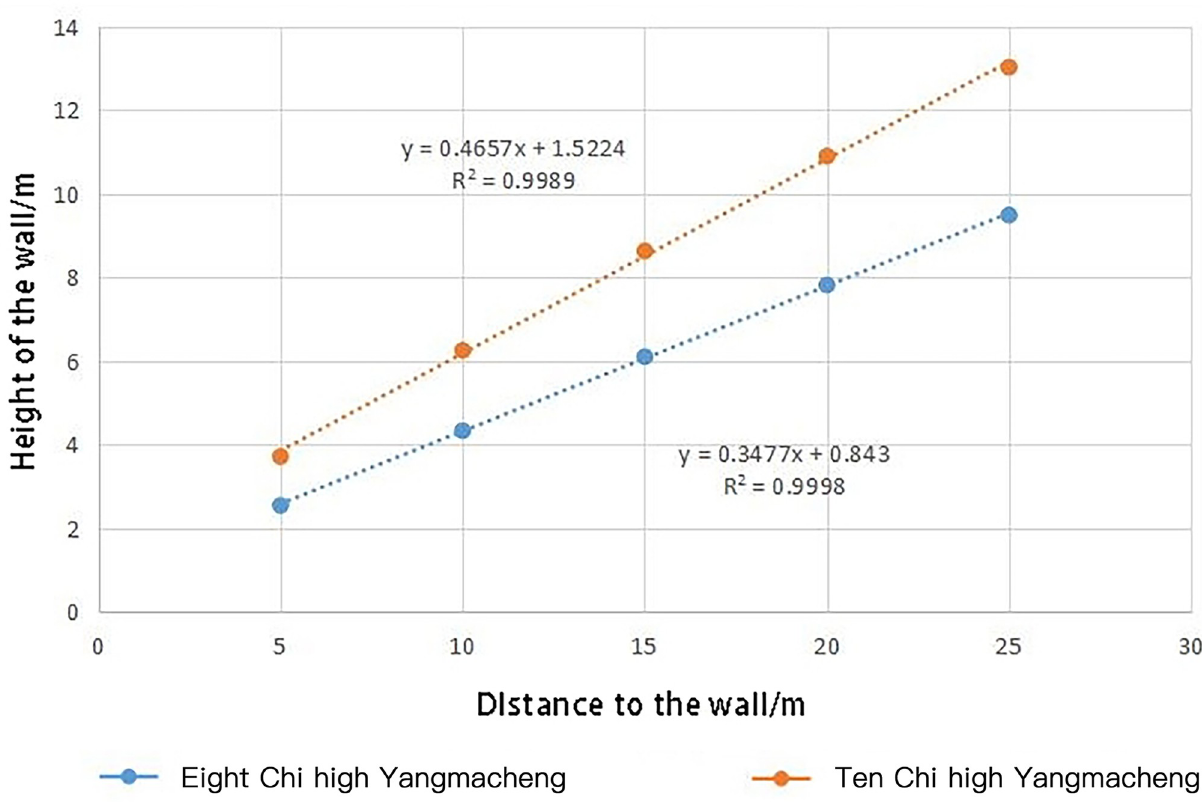
Fig 15. A linear relationship between wall height and the moat